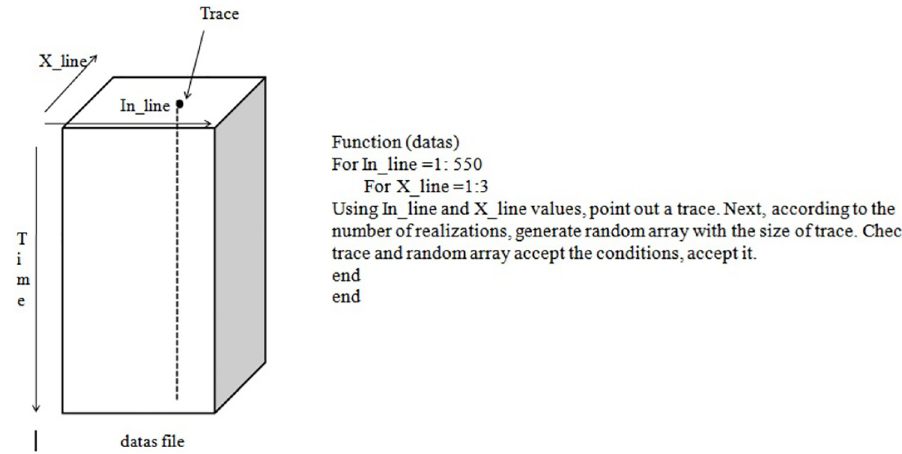
Fig 3. Stochastic inversion algorithm for seismic